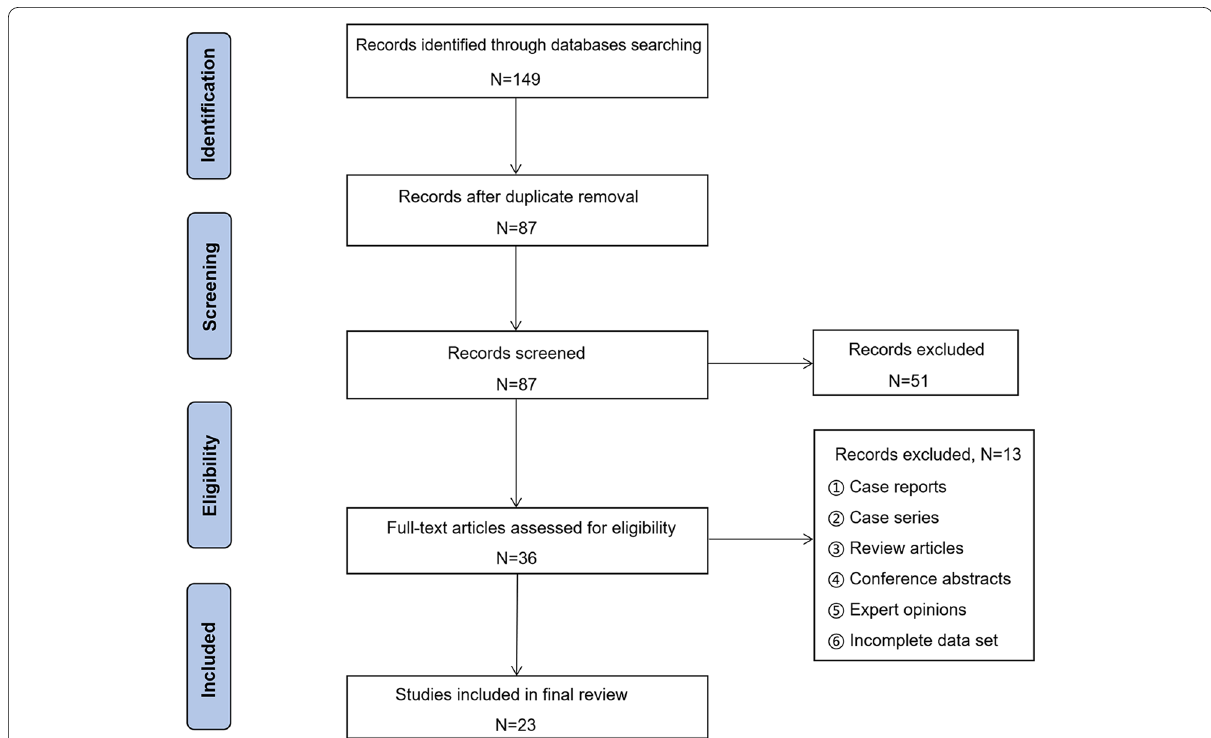
Fig. 1 Flow chart depicting the strategy used to select the relevant